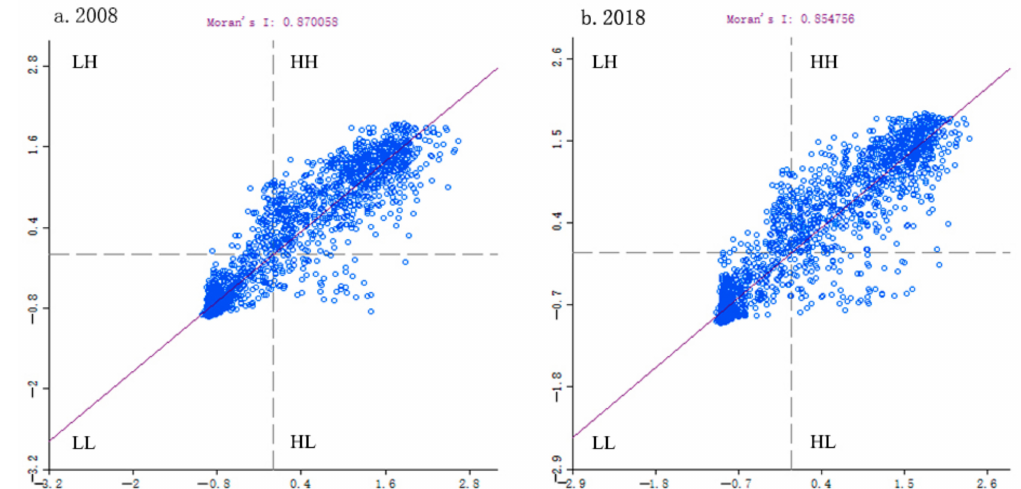
Figure 3. Moran scatter plots of MODEI in Fuyun County in 2008 and 2018. Note: HH: High–high cluster; LL: Low–low cluster; HL: High–low cluster; LH: Low–high